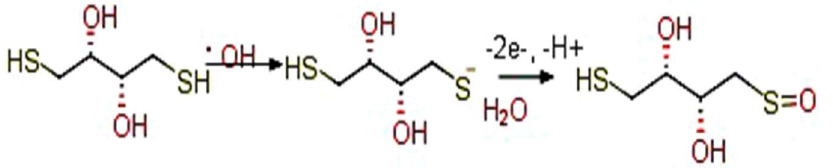
Figure 2. ( A ) SEM micrograph of the bare electrode illustrates the surface is least heterogeneous with an average surface roughness of 0.03 μm. ( B ) DPV of the bare gold electrode in 0.1 M phosphate buffer, pH 7.0 (black curve) with DTT adsorbed on the gold surface (red